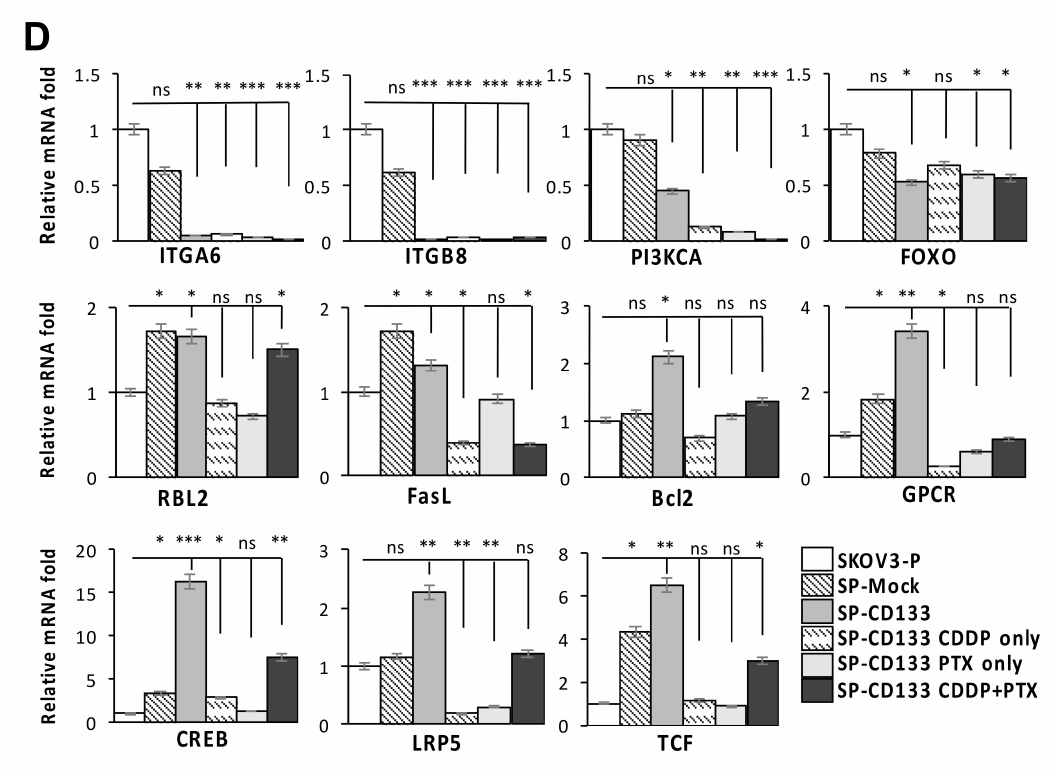
Figure 6. Overexpression of cluster of di ff erentiation 133 (CD133) in SKOV3 spheres with CD133 transduction (SP-CD133) induced the reduction of extracellular matrix (ECM) receptor interactions / focal adhesion and promoted cell cycle progression. ( A ) The heatmap of the di ff erentially expressed genes (DEGs) extracted from the three SKOV3-related modules including SP-CD133, SKOV3 spheres with mock-transduction (SP-Mock), and parental SKOV3 (SKOV3-P) cells. ( B ) KEGG pathway enrichment analysis of all DEGs. ( C ) Simplified diagram of key factors / pathways modulated by CD133. ( D ) Representative RT-qPCR analysis comparing expression levels of ITGA6, ITGB8, PIK3CA, FOXO3, RBL2, FasL, Bcl2, GPCR, CREB, LRP5, and TCF. Data shown were acquired from three independent experiments. * p < 0.05; ** p < 0.01; *** p < 0.001, ns: not